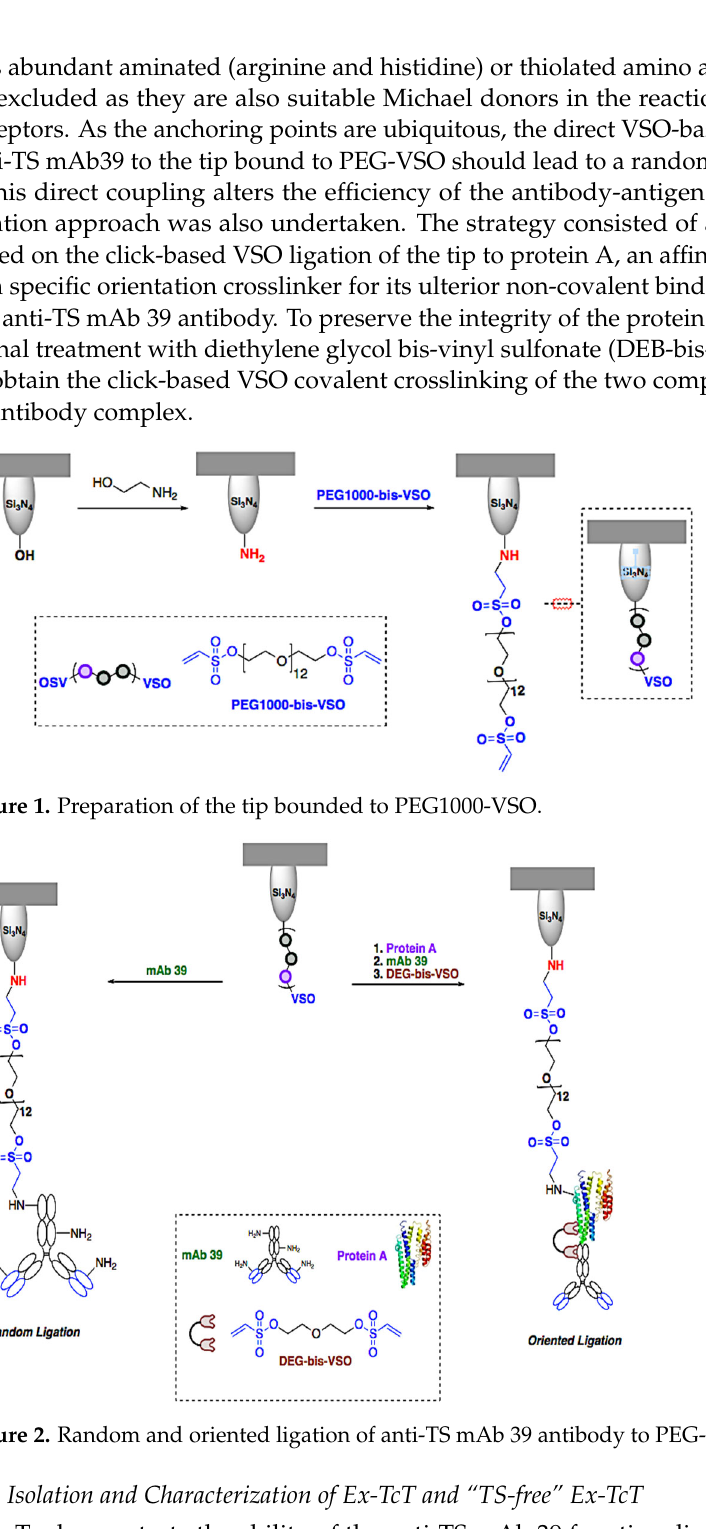
Figure 1. Preparation of the tip bounded to PEG1000 ‐ VSO.